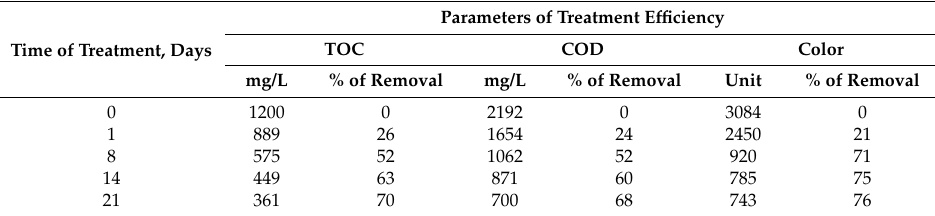
Table 1. Batch anaerobic treatment of wastewater in the columns.